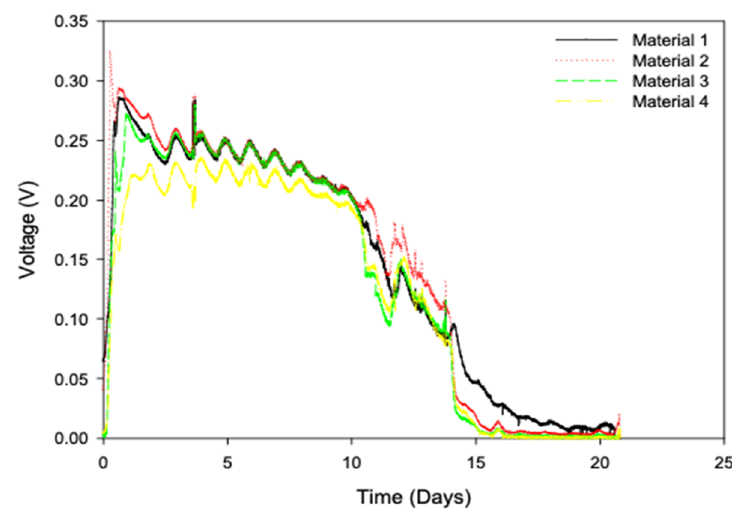
Figure 1. MFC potential development of four different carbon material types (1—felt, 2—E-Tech, 3—graphite rods, 4—graphite) fed with 5mMol sucrose. Closed-circuit MFC with a fixed resistance of 1000 Ω.